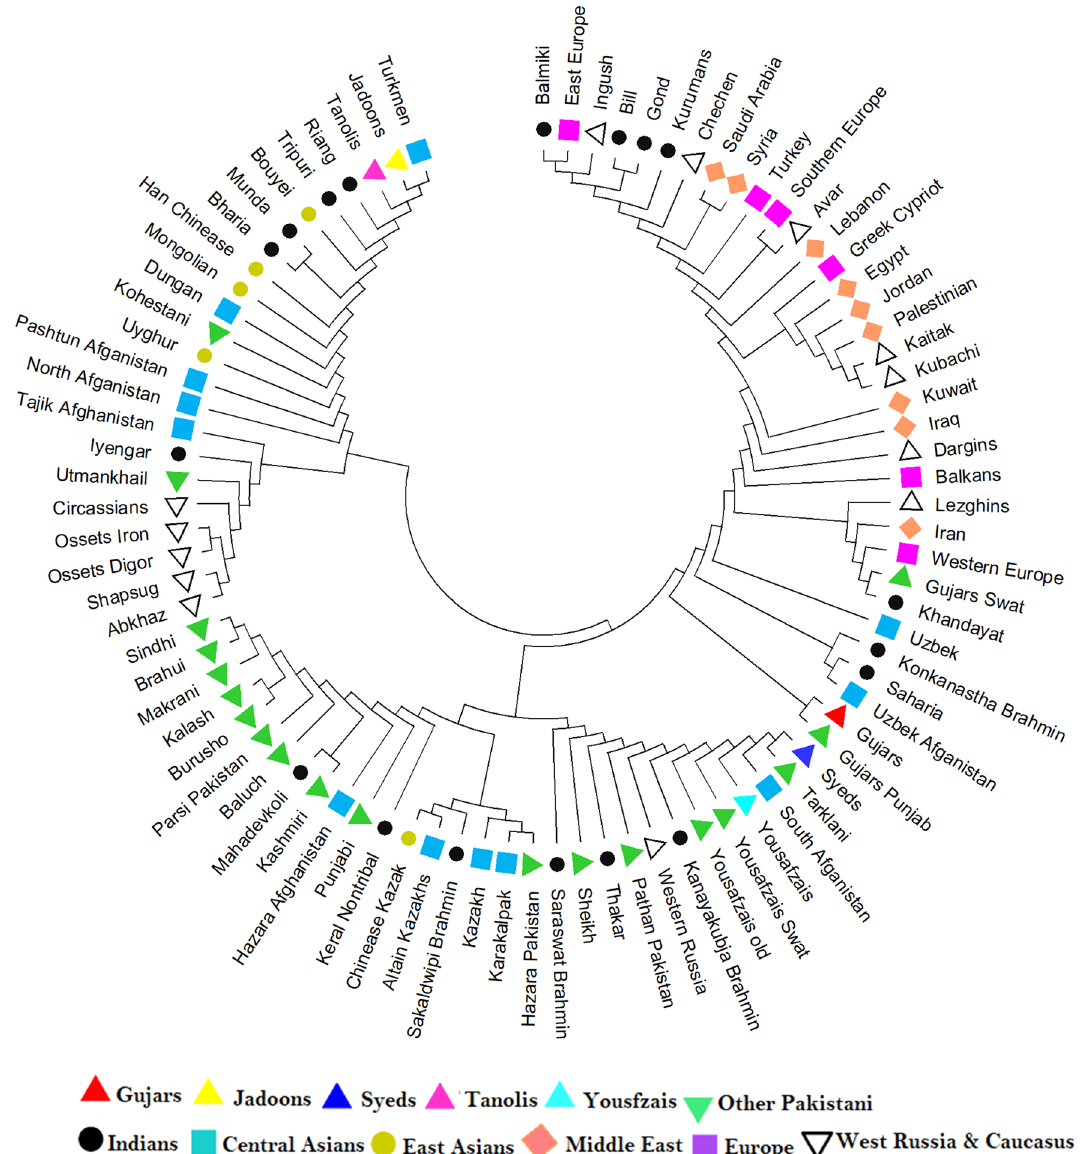
Figure 4. A Neighbor-Joining tree showing the genetic relationships between KPP ethnic groups and 82 world populations based on R ST estimates from Y-STR haplotype data (Table